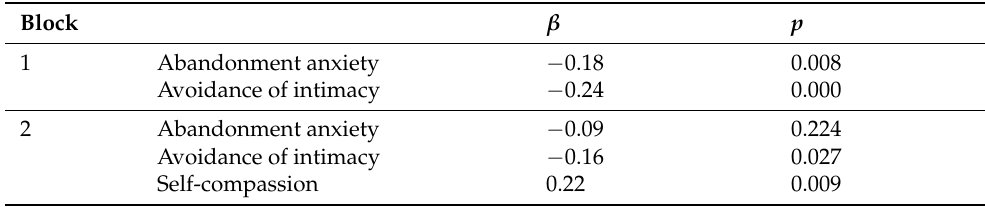
Table 3. Results of the hierarchical linear regression for intuitive